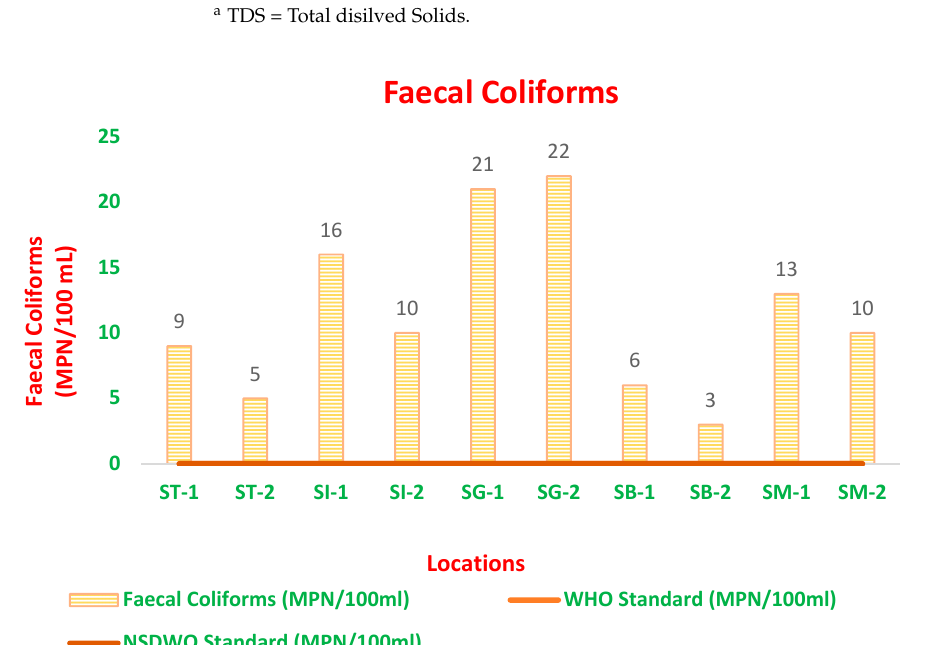
Figure 3. Faecal coliforms in drinking water at selected locations in Lahore, Pakistan.